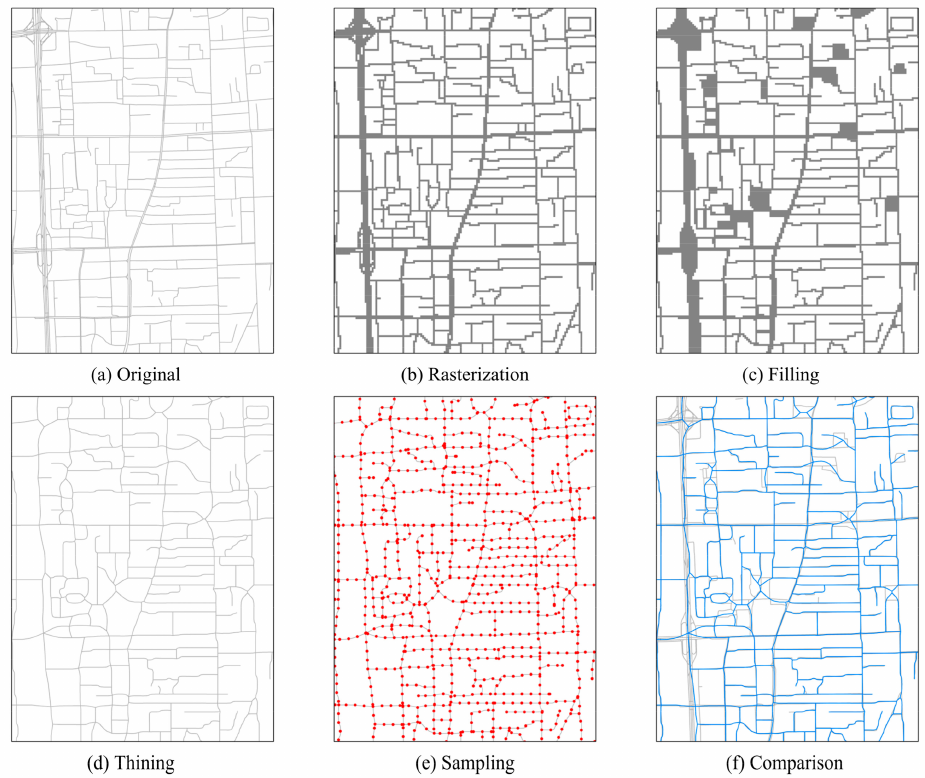
Figure 2. Road network simplification